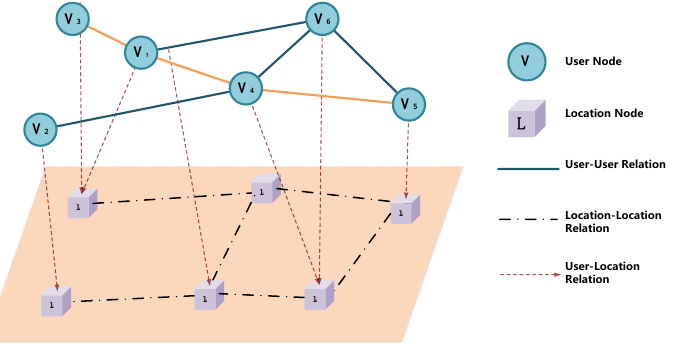
Figure 3. A concept map showing the structure of the location-based social network model